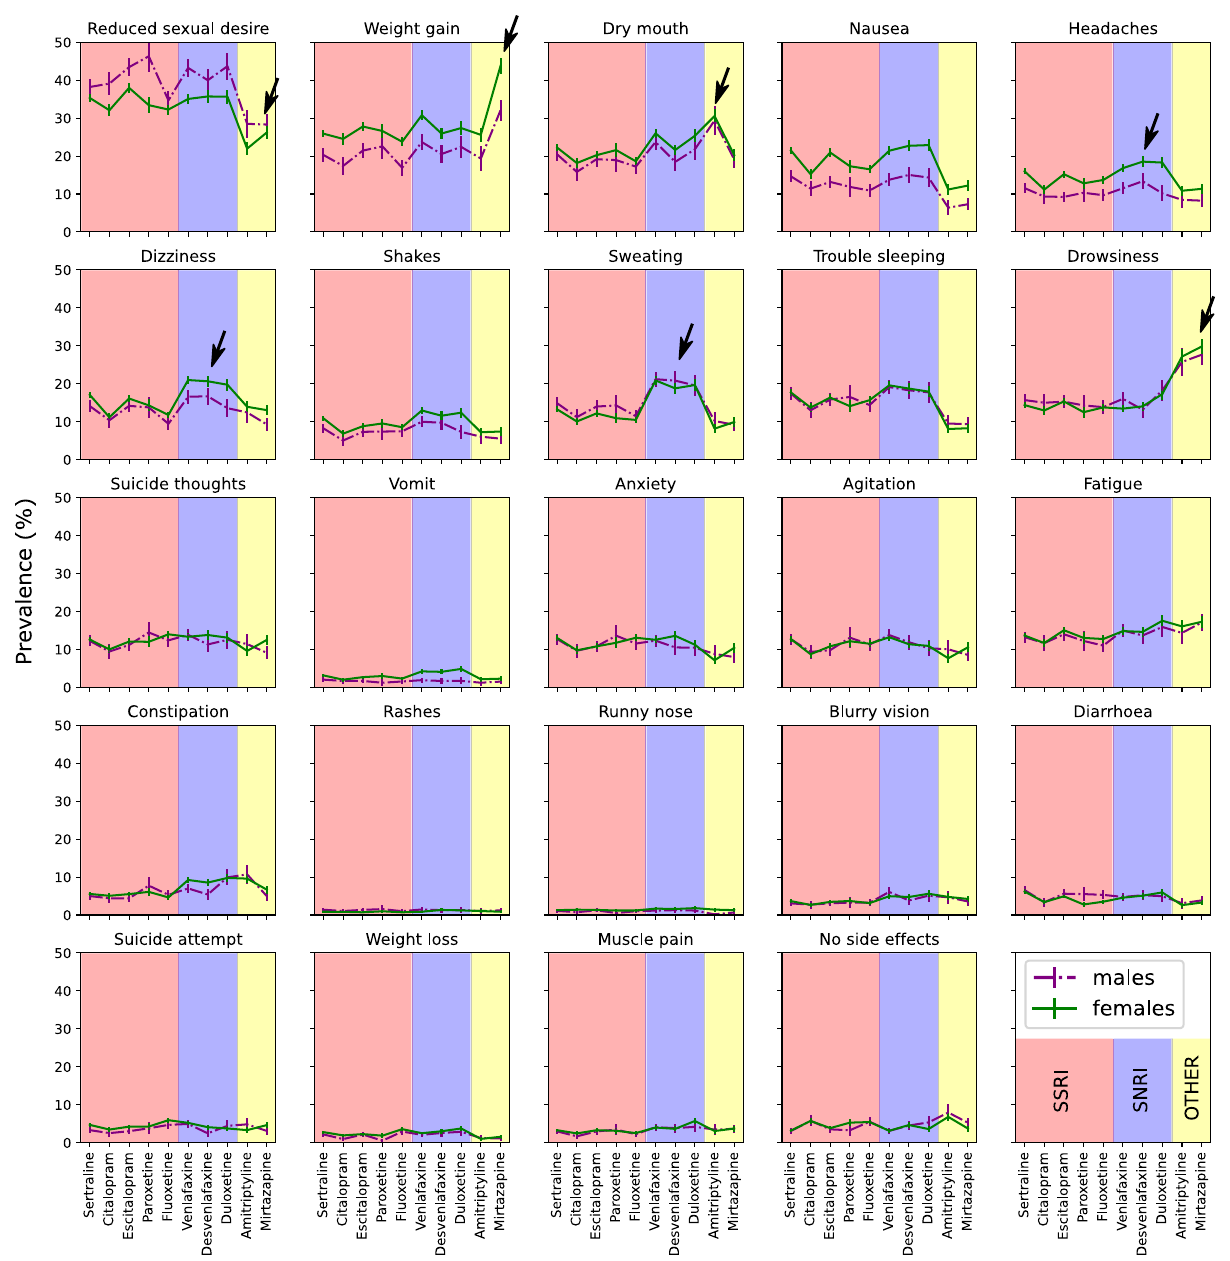
Fig. 1 Side effect prevalence across medications. Plots depicting the prevalence and 95% con fi dence interval for each of the 25 studied side effects across ten medications. Results are split by males (dotted lines) and females (solid lines). The plots are shaded according to antidepressant drug class. Some of the fi ndings discussed in the results are highlighted by black arrows. p -values are available in Supplementary Data 1. SSRI-Selective serotonin reuptake inhibitors;SNRI — serotonin and norepinephrine reuptake